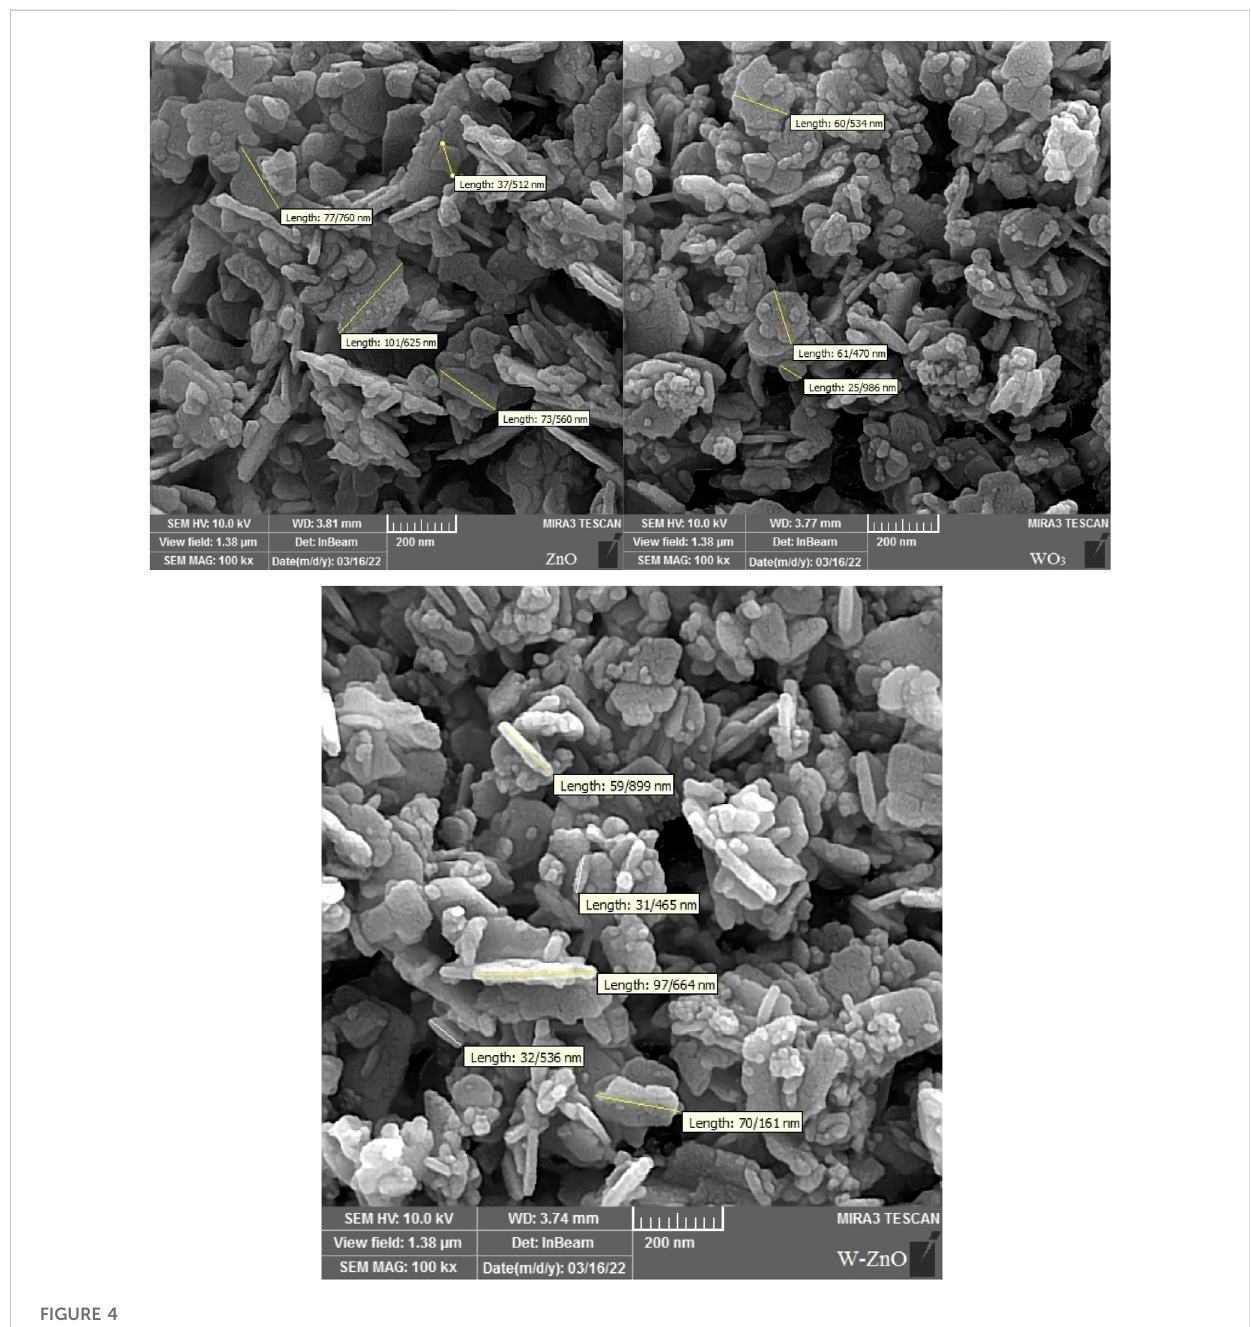
FIGURE 4 SEM images of ZnO, WO 3 and